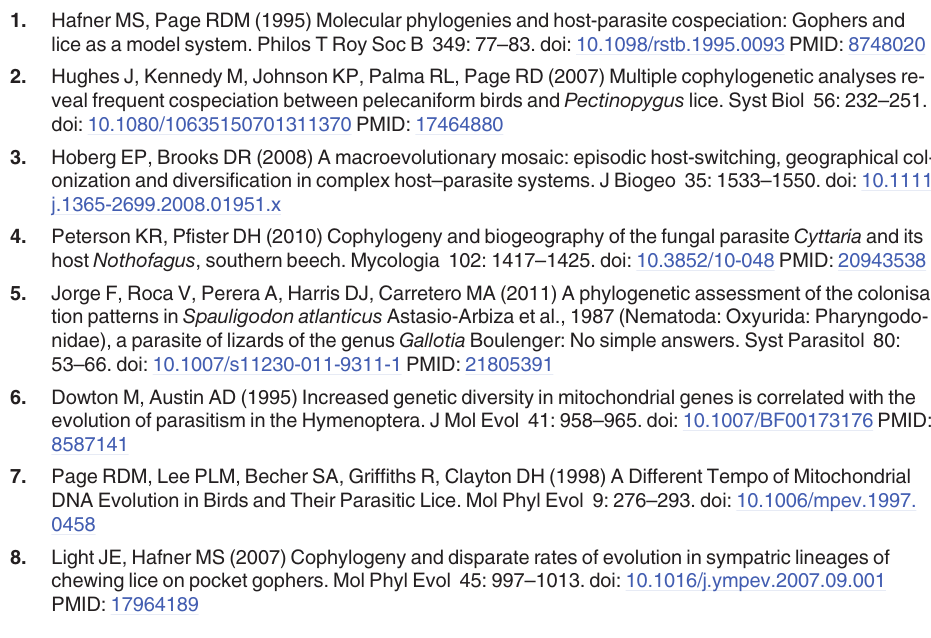
S1 Table. Pairwise F ST for (A) guppies and (B) lineages of Gyrodactylus poeciliae (GpCM), G. bullatarudis (Gb1 and Gb2), and G. turnbulli (GtC), respectively. The symbol † corre- estimated for lineage Gb2. Non-significant F values are sponds to the only pairwise F ST ST highlighted in bold. S2 Table. Morphological measurements of Gyrodactylus bullatarudis , G. poeciliae and G. turnbulli (mean±1 standard deviation followed by the range in parentheses). Measure- ments are provided in micrometres. Abbreviations: H = hamulus; VB = ventral bar; MH = marginal